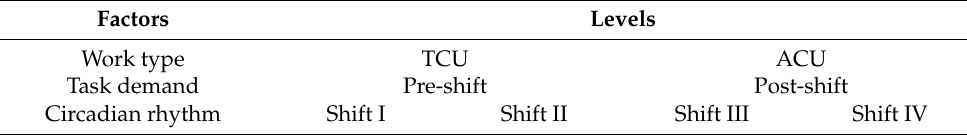
Table 3. Description of the 2 × 2 × 4 three-factor mixed experimental